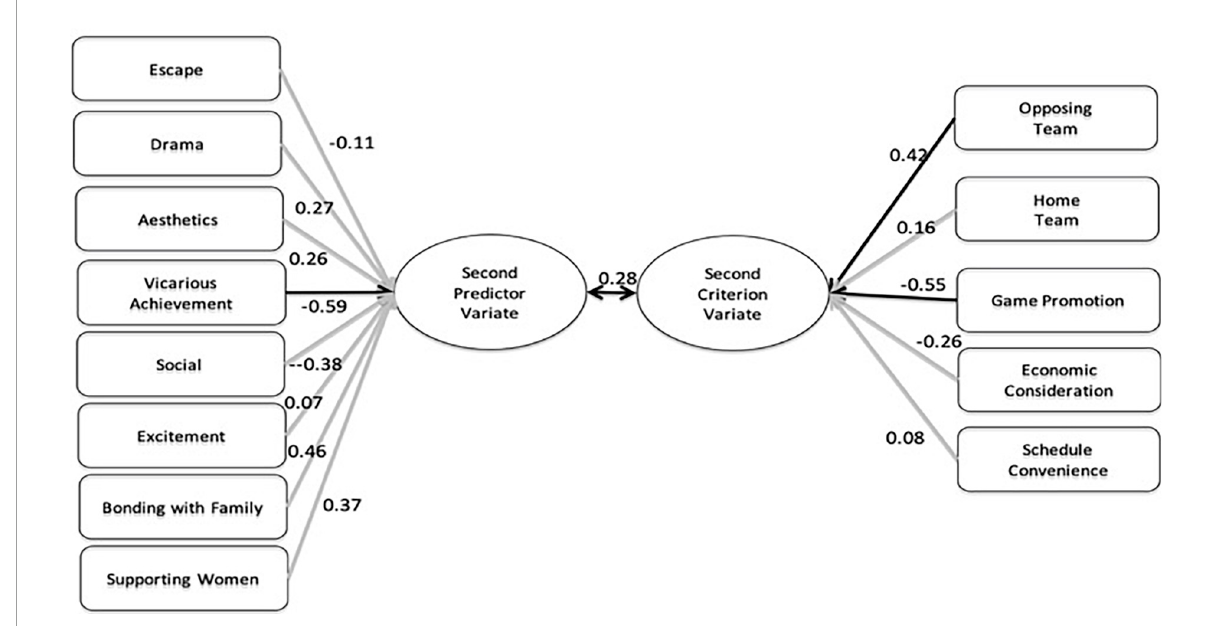
FIGURE2 Canonical functions with primary contributing factors canonical functions